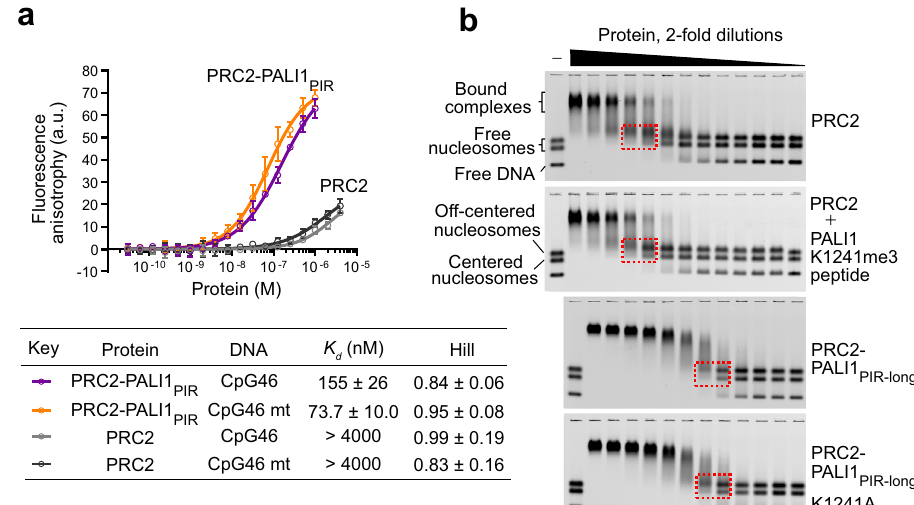
Fig. 6 PALI1 facilitates DNA binding by PRC2. a Fluorescence anisotropy used to quantify the af fi nity of PRC2 complexes to fl uorescein-labelled CpG46 or CpG46 mt DNA. Data represent the mean of three independent experiments that were carried out on different days and error bars represent standard deviation. Dissociation constants ( K d ) and Hill coef fi cients are indicated in the table, including their standard error. Fluorescence anisotropy values are in arbitrary units (a.u.). b EMSA used to quantify the af fi nity of the indicated PRC2 complexes for a mixture of Cy5-labelled mononucleosomes and free DNA of the same sequence. Dashed boxes indicate the mononucleosome bands near the K d concentration of the protein, where half of the labelled mononucleosomes are shifted (for quanti fi cation, see Supplementary Fig. 6b, c). Source data for a are provided as a Source Data fi